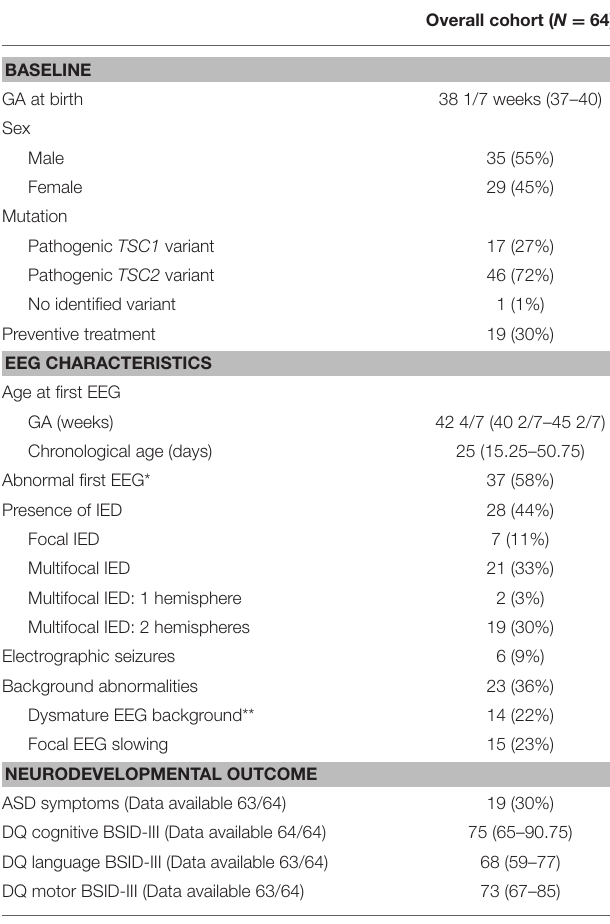
TABLE 1 | Baseline and EEG characteristics of the study cohort and neurodevelopmental outcome at 24 months.